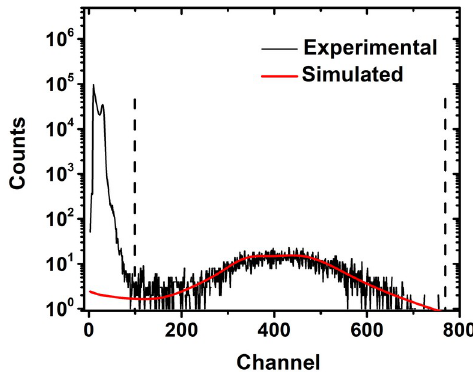
Figure 5. A typical beam-on spectrum obtained with a mi- cromegas detector (black line), in which the α -background is the peak in the low channel region, while the ff are those in be- tween the two dashed lines. In addition, the result of the GEF and FLUKA codes convoluted with the response function of the detector is presented, as red line and it was used to determine the f cut